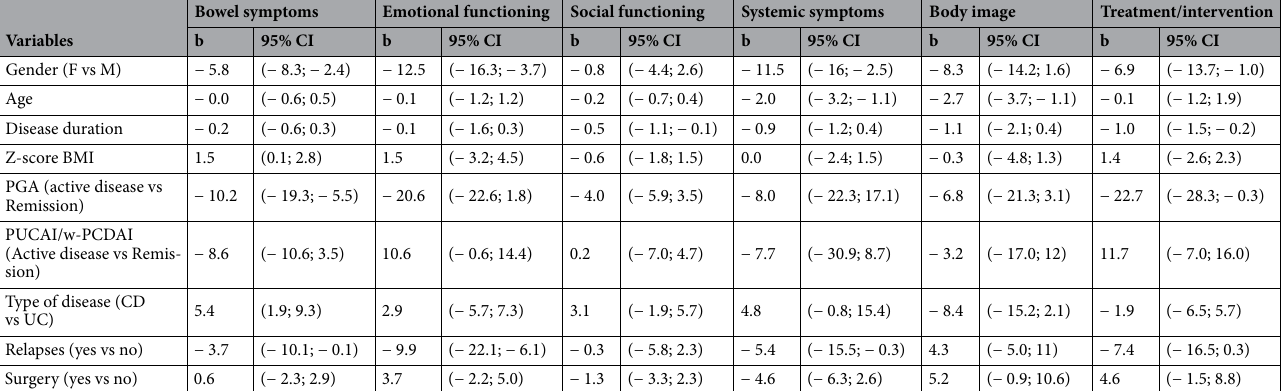
Table 5. Factors associated with IMPACT-III domains. Results of quantile regression analysis. b quantile regression coefficient estimate, 95%CI 95% confidence interval. Significant coefficients are marked in